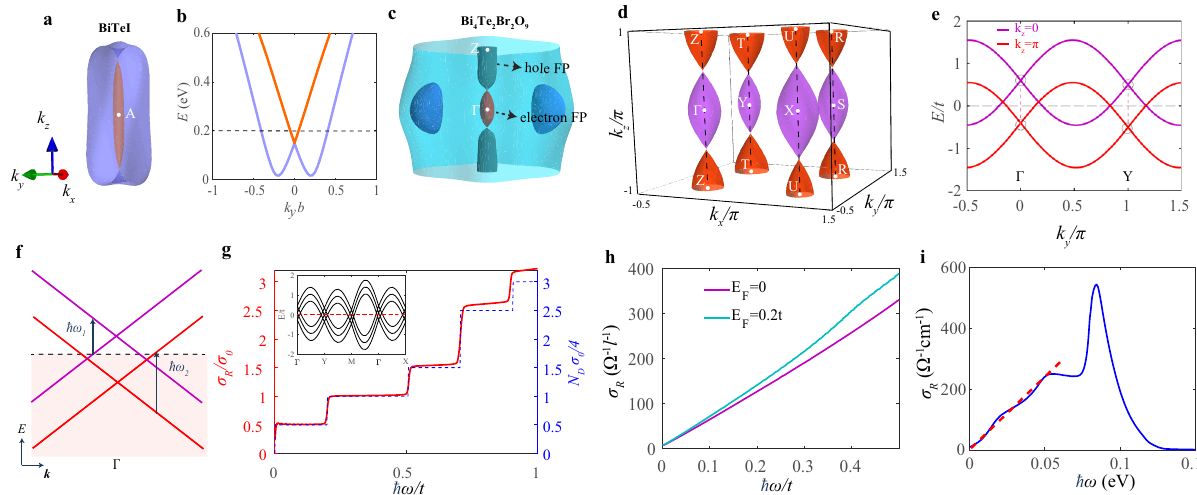
Fig. 3 Spindle torus and octdong Fermi surfaces. a The Fermi surface of BiTeI with Fermi energy E F = 0.2 eV, which cuts through the KNL Γ – A. The inner (orange) and outer (purple) Fermi pockets (FP) together form a spindle torus. The energy dispersion at a fi xed k z indicated by the dashed line is shown in b . b The Rashba-like energy dispersion for a fi xed k z . c The Fermi surface of Bi 4 Te 2 Br 2 O 9 (SG no. 25, Pmm 2) with Fermi energy E F = 0.05 eV, which cuts through the KNL Γ – Z. The labeled hole and the electron Fermi pockets together form an octdong-type Fermi surface. d The Fermi surface from the two- ð k Þ with m = 0.05 t , m = 0.05 t , m = 0.5 t , v = t , v = t , E = 0, and t = 1 as the unit of the hybridization energy. The positions band tight-binding model H x y z x y F 0 of TRIMs depicted are all connected by four KNLs in the k z -direction. e The energy dispersion for a fi xed k z = 0 (purple) and k z = π (red) in d . f Schematic plot of optical excitations that contribute to the optical conductivity for the hole-type (electron-type) Dirac fermions with onset frequency ω 1 ( ω 2 ). The horizontal dashed line denotes the position of Fermi energy. g The optical conductivity σ R (left axis) and estimated optical conductivity N D σ 0 /4 (right axis) ¼ 1 ∑ θ ð _ ω (cid:3) j 2 E jÞ with θ as the Heaviside step function, n as band versus frequency ω for a three-layer slab, where the number of Dirac points N Γ ; n Γ ; n D 2 index, and Γ labeling four TRIMs. The inset fi gure in g shows the band structure of this trilayer slab. h The bulk optical conductivity for the model material with octdong Fermi surface at E F = 0, 0.2 t with η = 0.002 t and temperature T = 0.01 t . Here, l (cid:3) 1 ¼ 2 π ~ a cm − 1 with ~ a ¼ a = Å and a as the lattice constant. i The bulk optical conductivity for Bi 4 Te 2 Br 2 O 9 with η = 1 meV and temperature T = 10 K. The slight deviation from linear dependence (red dashed line) for Bi 4 Te 2 Br 2 O 9 is due to the presence of the extra trivial pockets (blue pockets in c